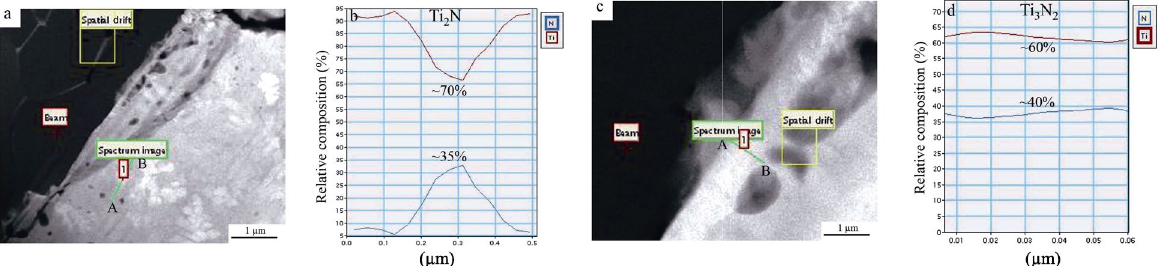
www.springer.com/journal/40145